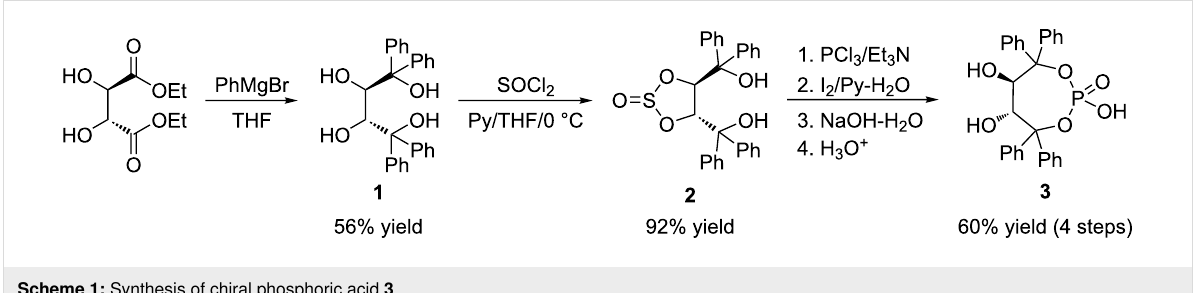
Scheme 1: Synthesis of chiral phosphoric acid 3